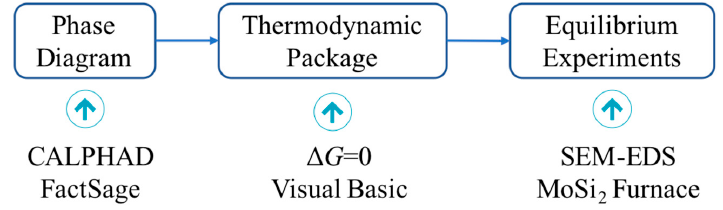
Figure 1. Research routine in this work.